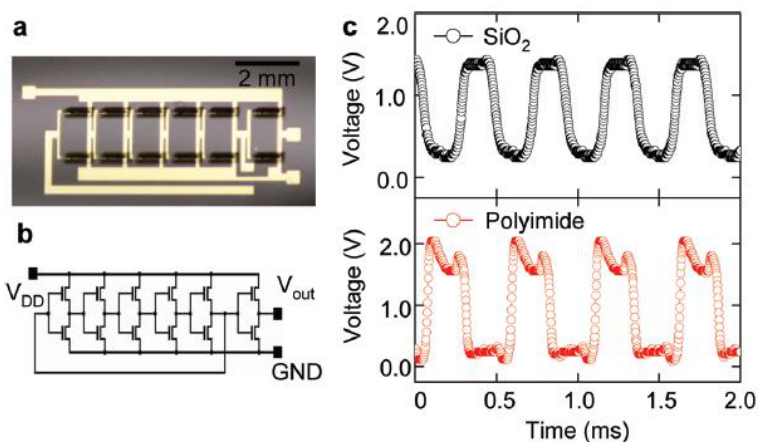
Figure 9. Five-stage ring oscillator network built with inkjet-printed CNT thin-film transistors with a drain voltage of 2.5 V [64]. ( a ) image of device ( b ) equivalent circuit ( c ) Voltage profile for devices built on SiO 2 and polyimide. Reprinted with permission from B. Kim, S. Jang, M.L. Geier, P.L. Prabhumirashi, M.C. Hersam, A. Dodabalapur, High-Speed, Inkjet-Printed Carbon Nanotube/Zinc Tin Oxide Hybrid Complementary Ring Oscillators, Nano Letters 14 (6), 2014 , 3683–3687. Copyright 2014 American Chemical Society.